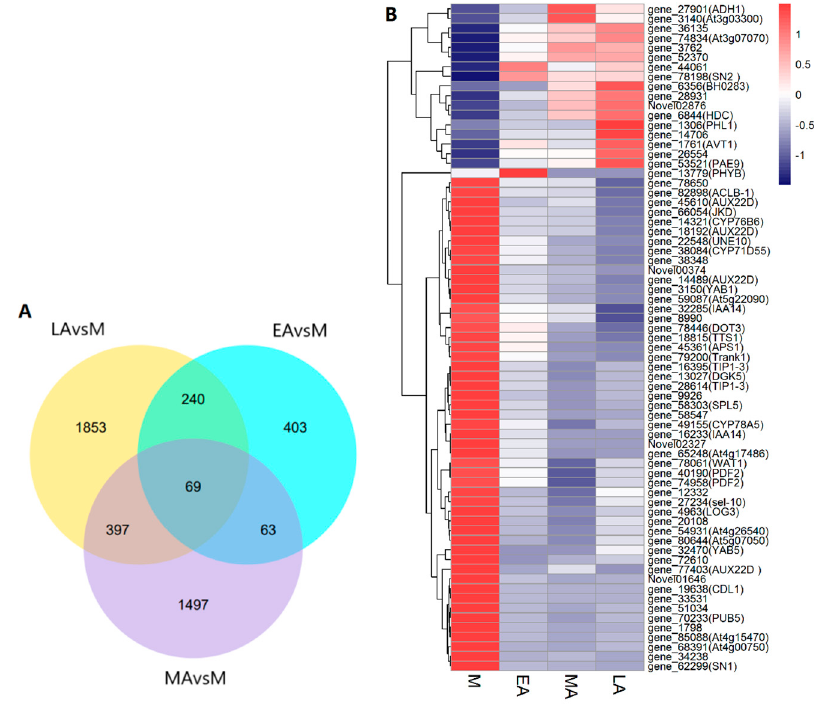
Figure 3. Venn diagram of differentially expressed genes (DEGs) and heat map of the 69 common DEGs. ( A ) Venn diagram of DEGs at three premature senescence stages compared with the mature stage. ( B ) Expression patterns of 69 common DEGs in the process of premature senescence. The x -axis represents each stage of premature senescence. The y -axis refers to gene expression levels. Log 10 (FPKM + 1) was used for the heat map to normalize the gene expression level. The gradient from blue to red indicates that the relative levels of gene expression range from low to high. FPKM, expected number of Fragments Per Kilobase of transcript sequence per Millions base pairs sequenced.